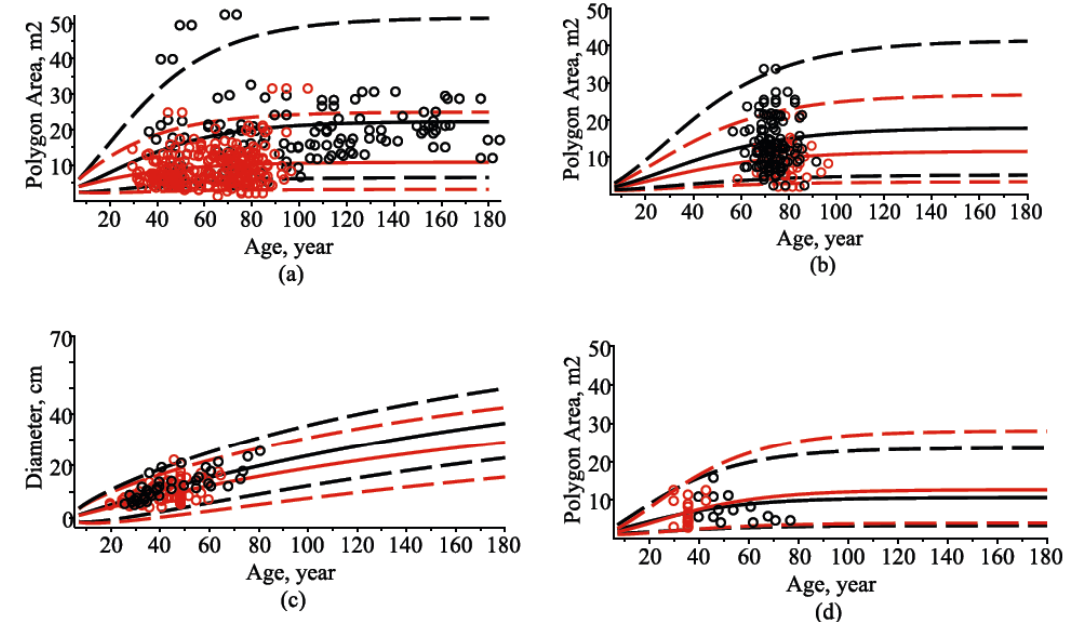
Figure 3. Kinetics of the mean, 0.05 quantile, and 0.95 quantile of the potentially available area for two randomly selected stands from a validation dataset: ( a ) all species; ( b ) pine ( Pinus sylvestris ); ( c ) spruce ( Picea abies) ; ( d ) silver birch ( Betula pendula Roth and Betula pubescens Ehrh.); solid line — mean trajectory; dashed line — quantiles trajectories; black — first stand; red — second stand; and circle — observed data.